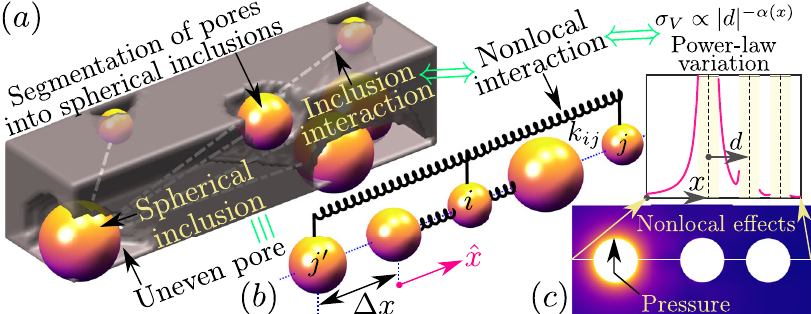
Fig. 1 Intrinsic variable-order fractional nonlocality in porous solids. a Segmentation of a porous structure into a network of hollow spherical inclusions interacting via long-range forces. Note that an inverted transparency map has been adopted to represent the bulk and the pores in order to facilitate the visualization of the segmentation. b Idealized discrete model of long-range interacting spherical inclusions. The discrete nonlocal spring connections capture the redistribution of elastic energy due to the presence of the pores. c Power-law spatial variation of the stress in a series of spherical